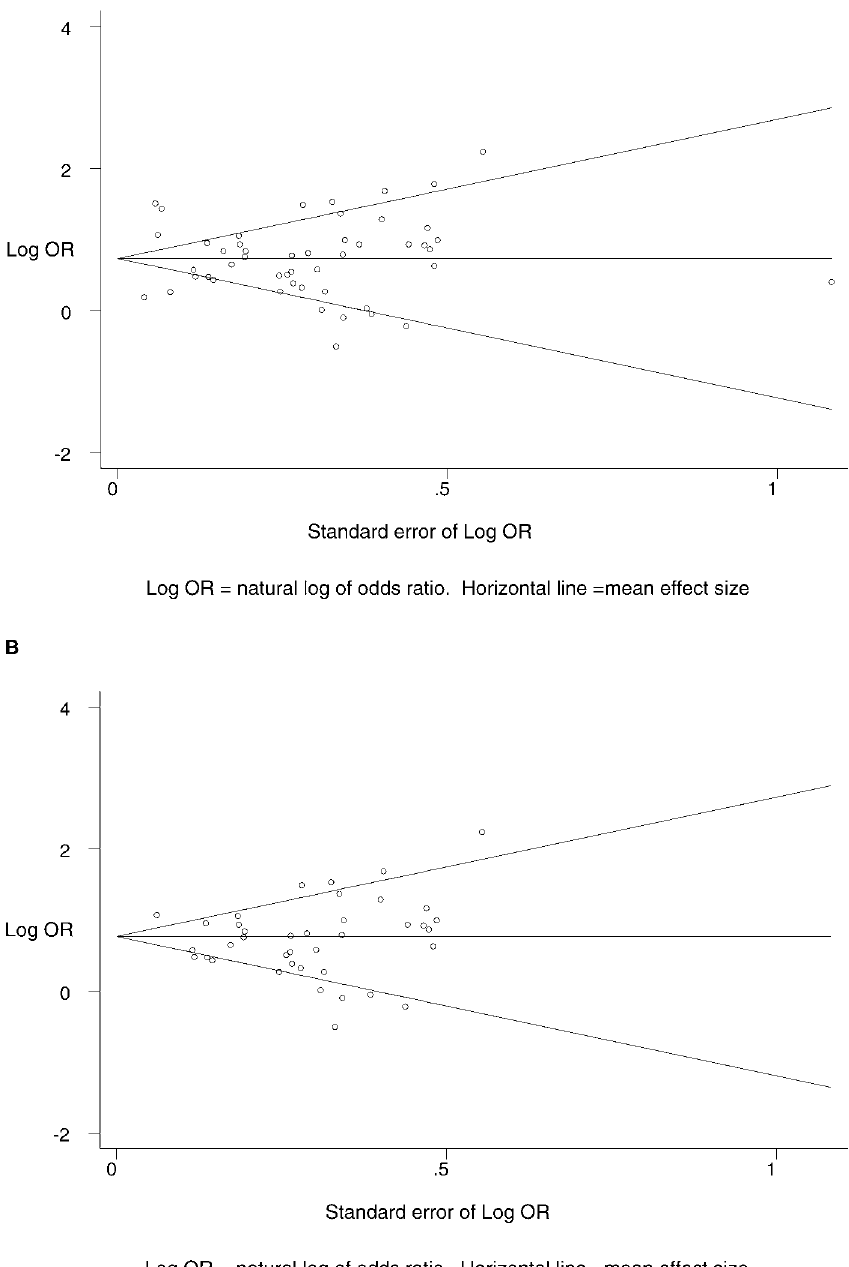
Figure 9. Begg’s Funnel Plots with Pseudo 95% Confidence Limits (A) Funnel plot for all studies. (B) Funnel plot for all studies excluding mortality